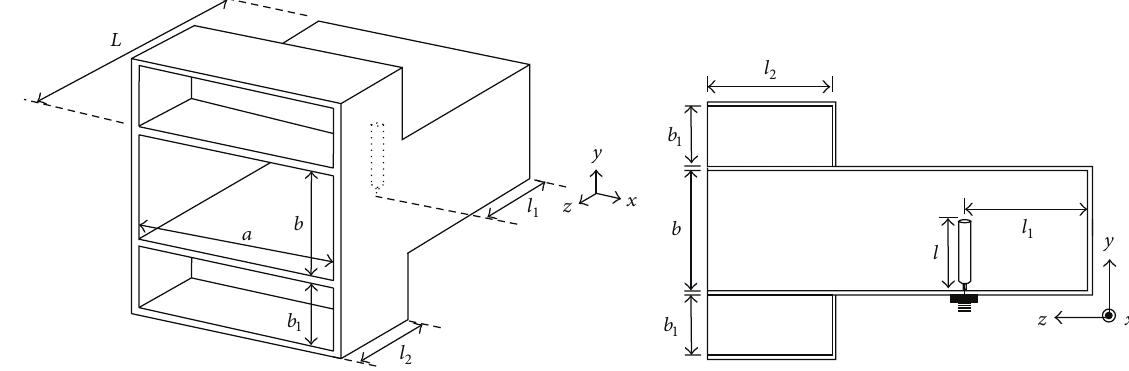
Figure 1: Geometry of the proposed